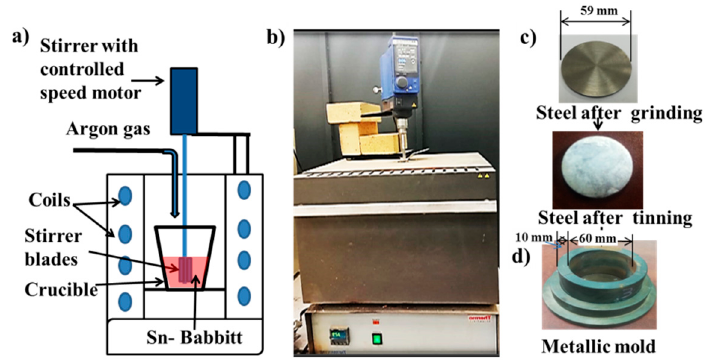
Figure 1. Furnace and mold used for preparing nanocomposite containing tin-based Babbitt alloy reinforced with alumina nanoparticles and carbon steel specimen before and after tinning, ( a ) Schematic drawing for furnace and stirrer, ( b ) photocopy of furnace and stirrer, ( c ) carbon steel substrate and ( d ) metallic mold.